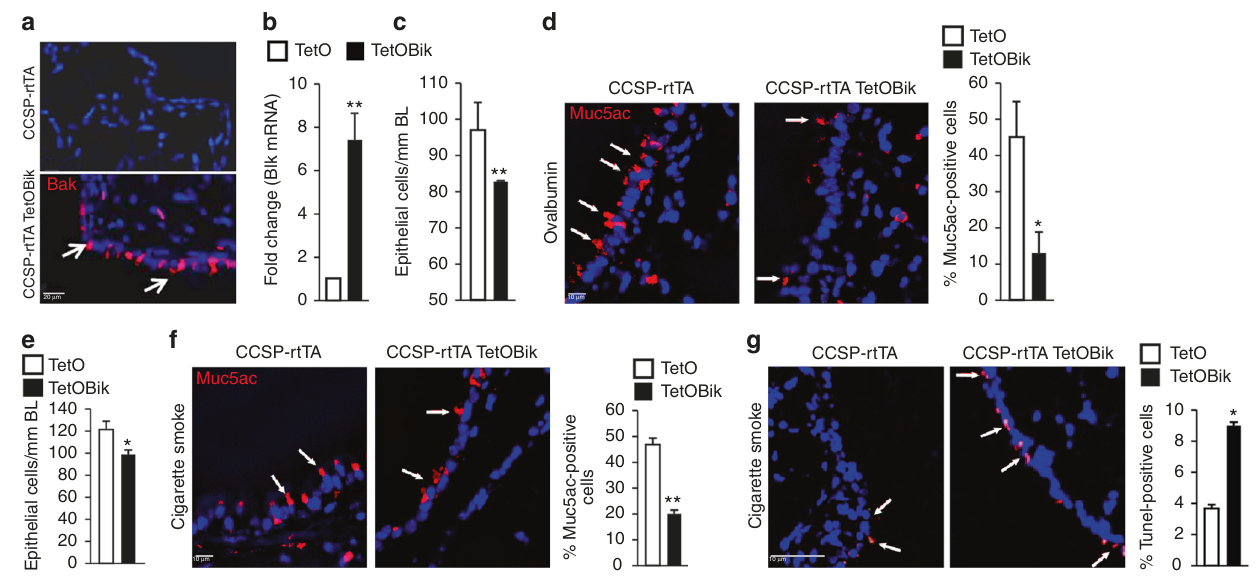
Fig. 5 Inducible expression of Bik in the airways of adult mice reduces allergen- or CS-induced MCM. CCSP-rtTA+/TetoBik − and CCSP-rtTA+/TetoBik+ mice were immunized with ovalbumin/Alum and exposed to ovalbumin aerosols for 5 days and on the following day instilled with 100 ng doxycycline or PBS intranasally. Lungs were collected 24 h later and analyzed for airway-speci fi c expression of ( a ) Bik protein by immunostaining and ( b ) Bik mRNA expression level by qRT-PCR. Representative micrographs of airways, white arrows indicate Bik-positive cells. c , d CCSP-rtTA and CCSP-rtTA/TetOBik mice were immunized with OVA/Alum and exposed to OVA aerosols for 5 days and instilled with doxycycline intranasally for 2 days after the last OVA exposure. The number of airway epithelial cells/mm BL ( c ) and the percentage of Muc5ac-postive cells ( d ) were quanti fi ed in AB/H&E stained or immunostained paraf fi n-embedded lung tissues. e , f Mice exposed to CS for 3 weeks followed by one time intranasal instillation of 100 ng doxycycline or PBS. CS-induced ECH ( e ) and MCM ( f ) were signi fi cantly reduced in the airways of CCSP-rtTA/TetOBik compared to CCSP-rtTA mice. White arrows indicate Muc5ac-positive cells. g Lung tissues were analyzed for internucleosomal DNA fragmentation using TUNEL assay. White arrow indicates TUNEL- positive cells. Differences between two groups were assessed for signi fi cance by Student ’ s t test. Error bars indicate ± SEM, ( n = 8 mice per group); * = P < 0.05; ** = P <